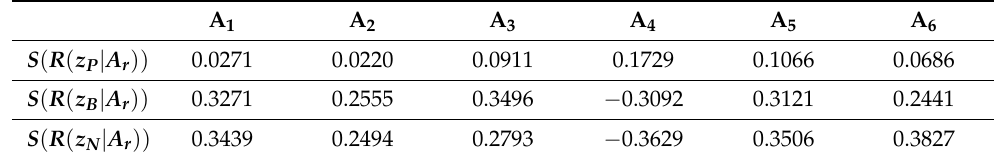
Table 7. The score function of expected losses by TOPSIS Method.